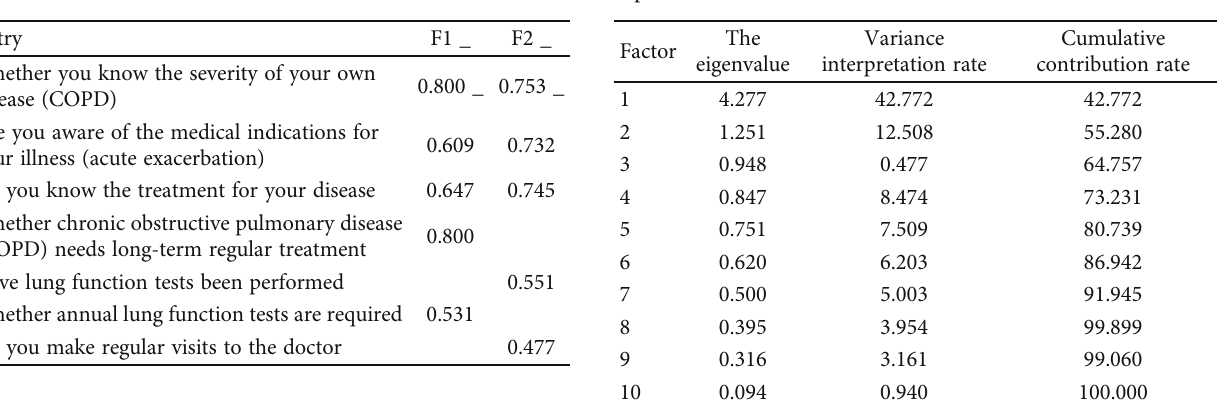
Table 3: Factor analysis of cognitive questionnaire for COPD patients.